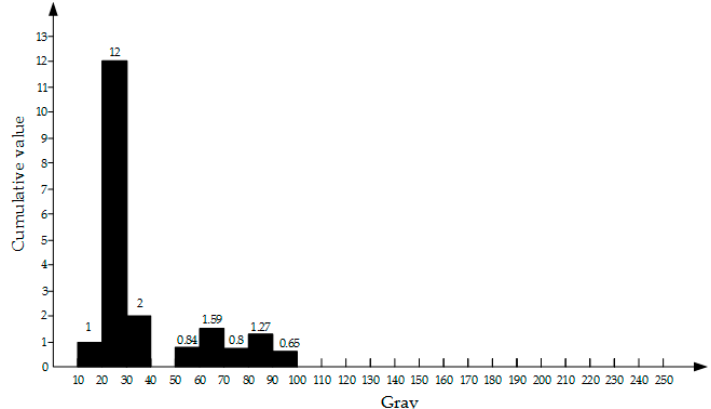
Figure 4. Road texture feature statistical model.